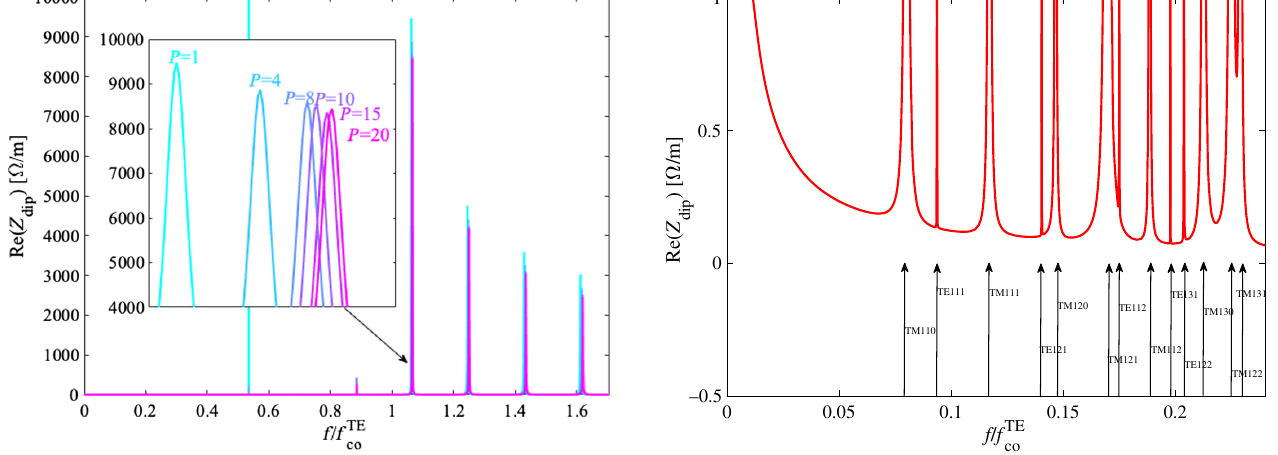
FIG. 3. Convergence of mode matching as a function of the number of radial modes P . Frequency is normalized over the first beam pipe propagating mode (TE 11 ). Mode matching parameters: